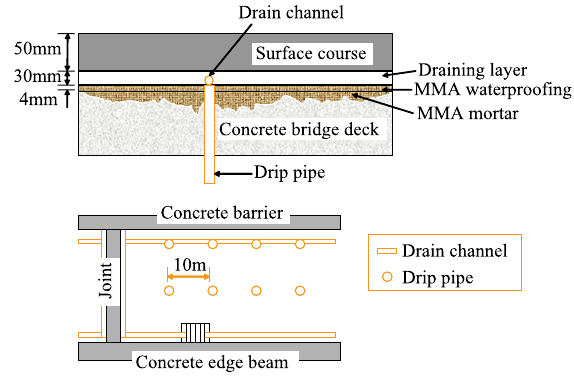
Fig. 8. Section view and plan view of bridge deck